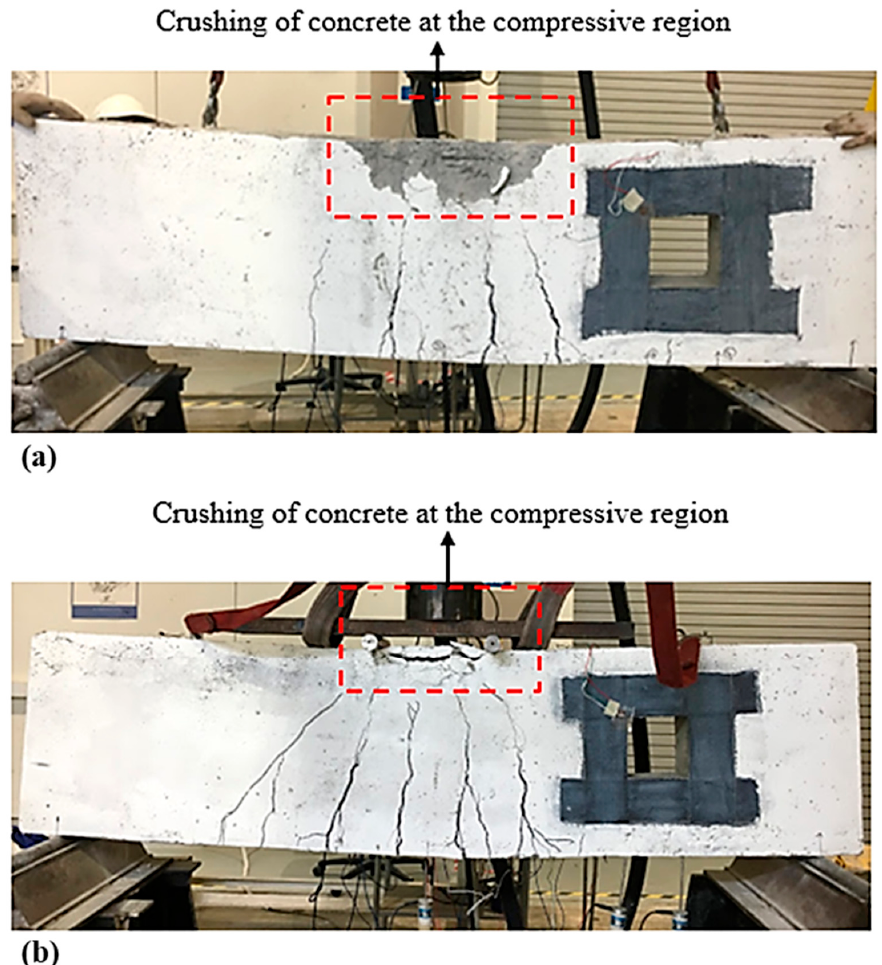
Figure 8. Failure mode and cracking pattern of the deep beam ( a ) B1b and ( b ) B1c.